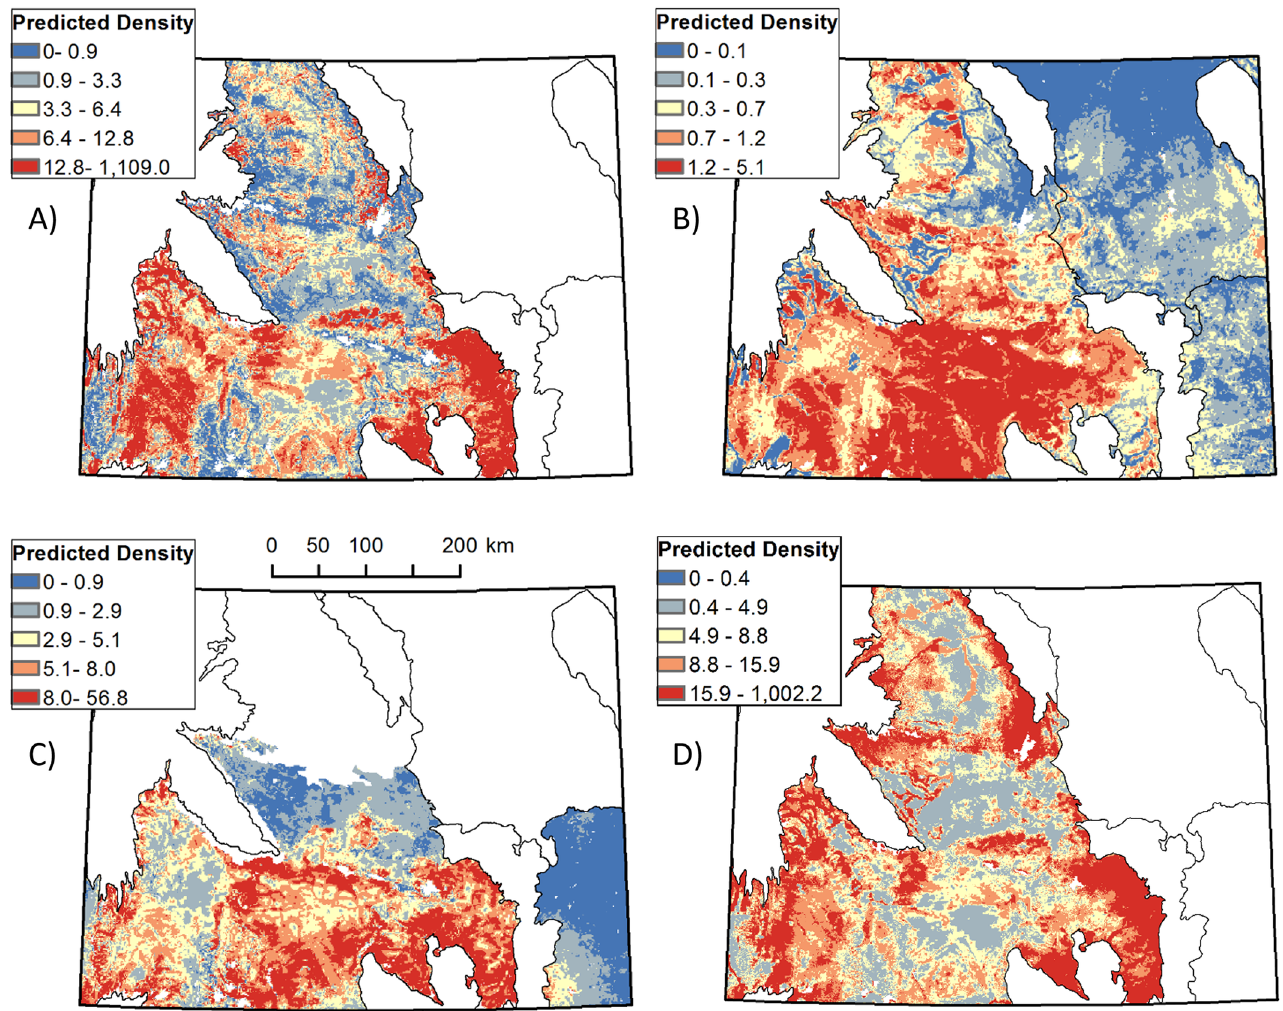
Fig 6. Spatial predictions of low to high density for each of the four small mammal species groups: A) white-tailed prairie dogs, B) least chipmunks, C) Wyoming ground squirrels, and D) leporids ( Sylvilagus sp. and Lepus townsendii ). Cool colors indicate lower density, warm colors higher. White areas in each map show mountainousecoregionswhich were not includedin the study area.